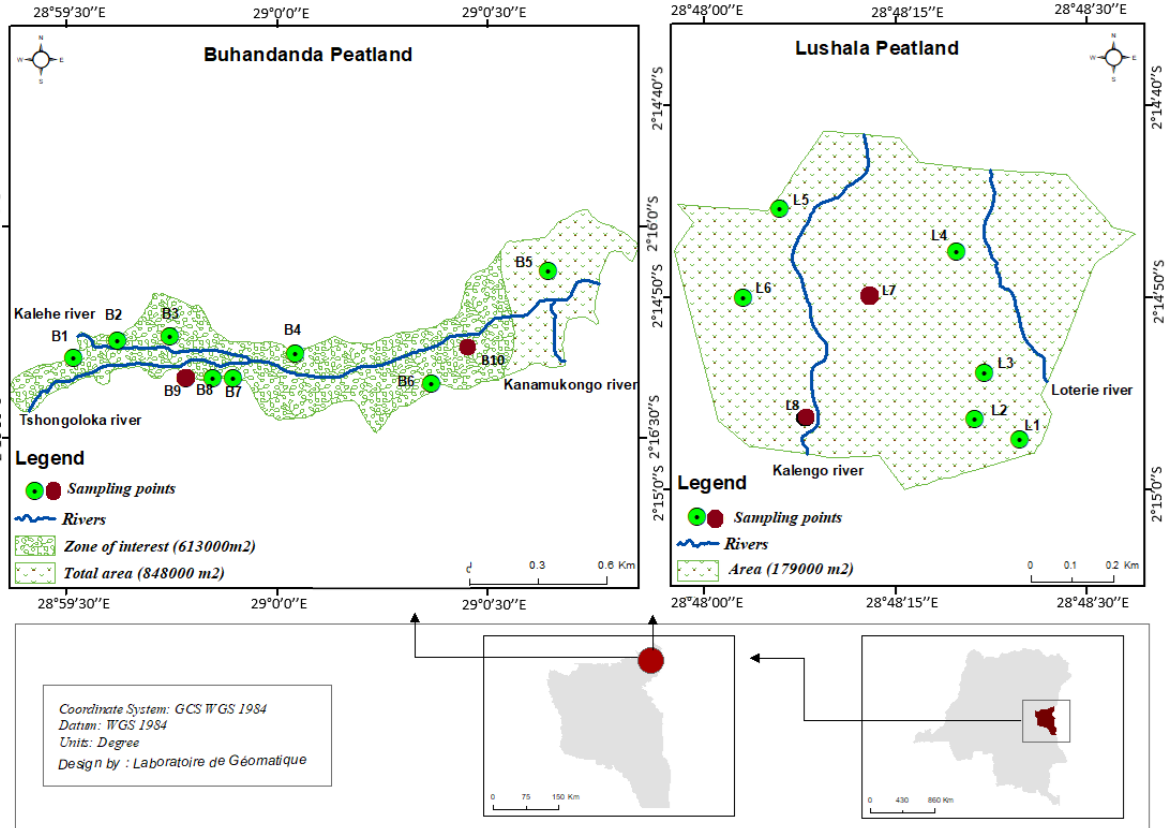
Figure 2. Locations of sampling points in the Buhandanda and Lushala peatlands. Short (70 cm) peat cores were collected at B1–4, B6–8 and L1–6 during the first (2017) field campaign (green dots), while long (200 cm) cores were collected at B9, B10, L7 and L8 in 2018 (red dots). Water table depth, pH (of peat) and peat thickness were measured at Locations B1–4, B6–9 and L1–8. No samples or data were collected at B5 because it did not have a peat layer. Insets show the location of Sud-Kivu Province within the DRC (right) and the location of the study area within Sud-Kivu Province